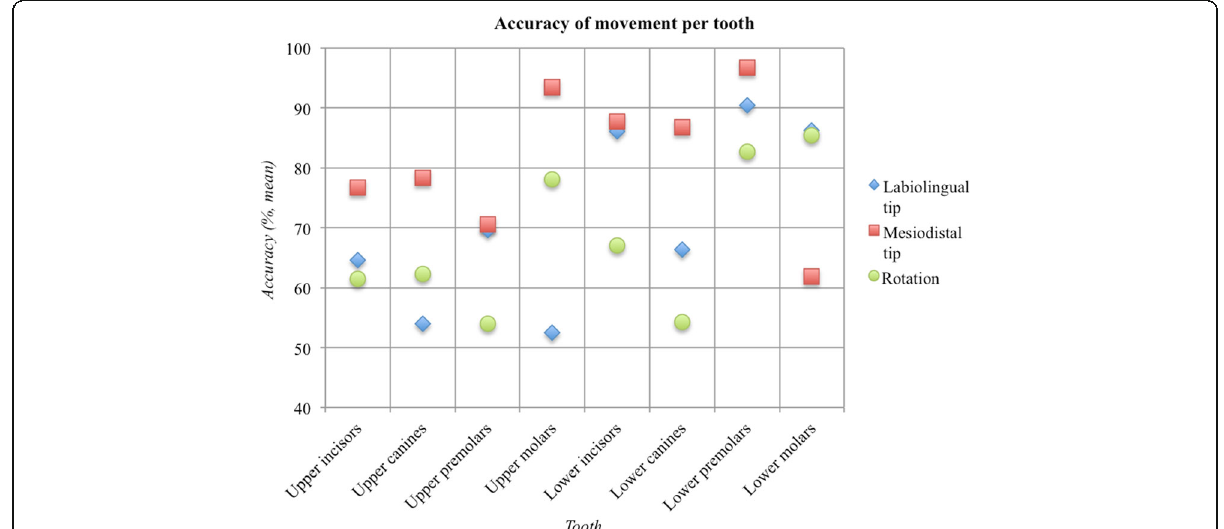
Fig. 6 Accuracy of planned movements by tooth